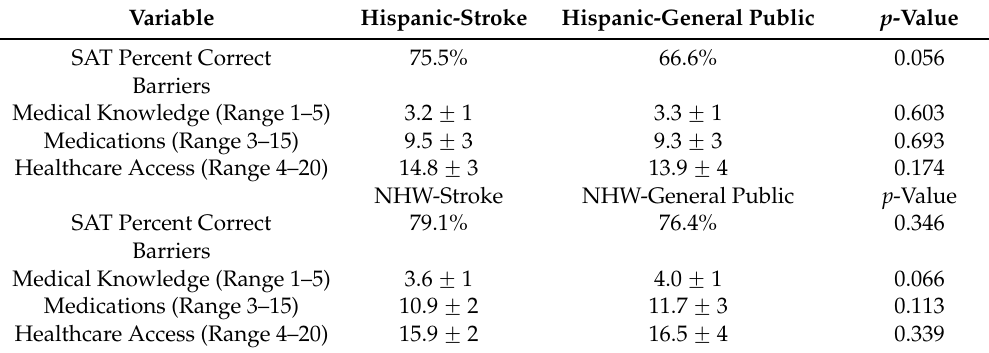
Table 4. Comparisons between stroke patients and general public participants: Hispanics and